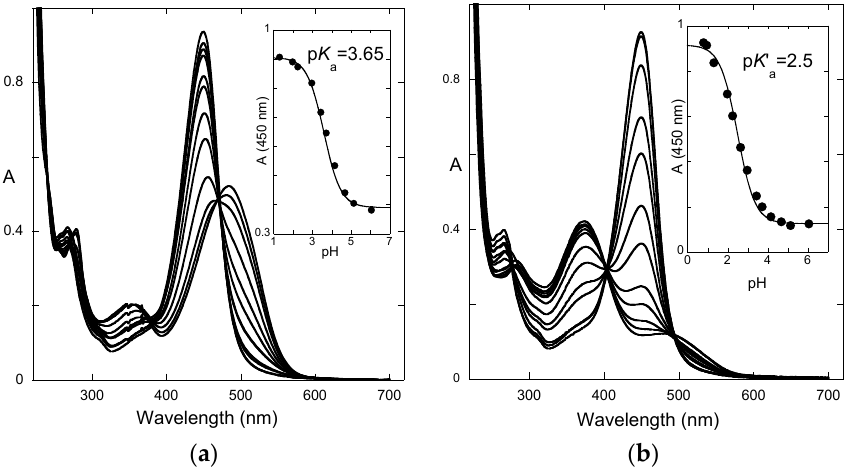
Figure 8. UV-visible spectra of P5 (4 × 10 − 5 M) recorded: ( a ) immediately after a direct pH jump; and ( b ) at equilibrium.